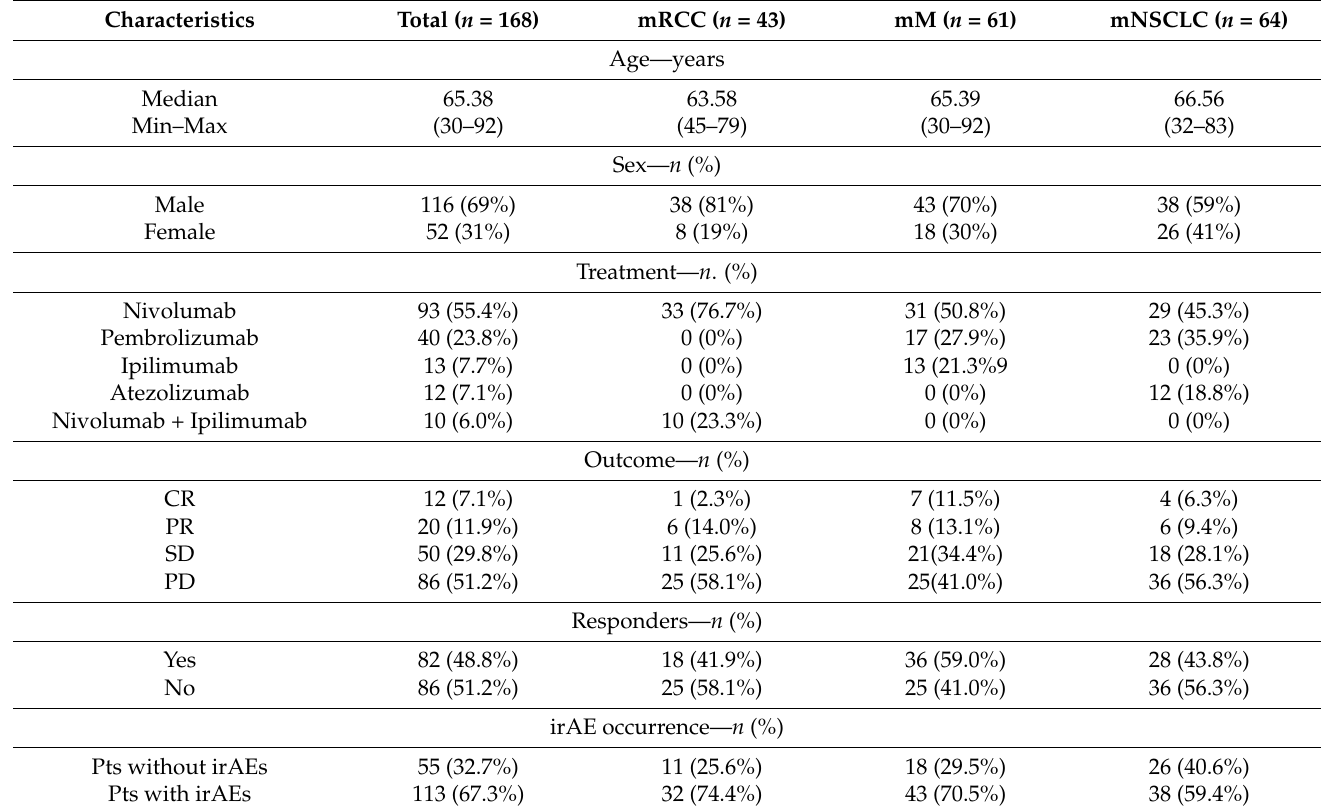
Table 1. Patient characteristics.